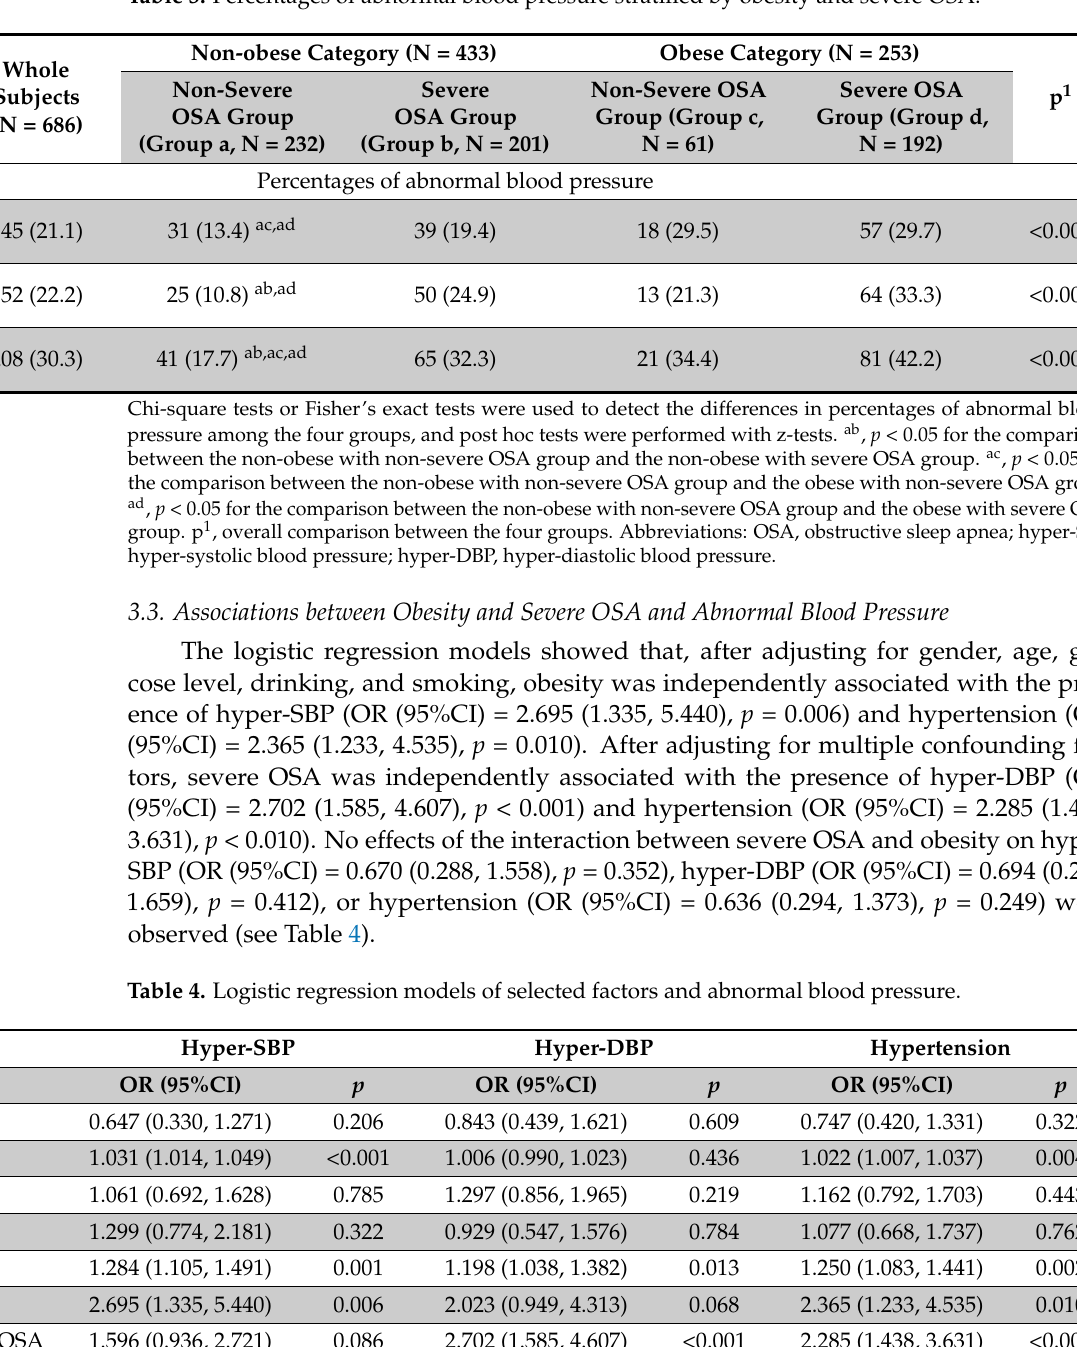
Table 3. Percentages of abnormal blood pressure stratified by obesity and severe OSA.